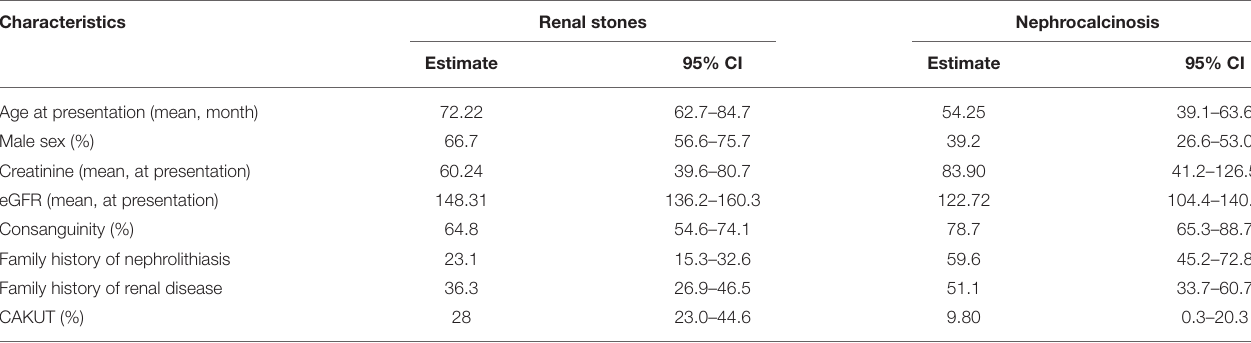
TABLE 2 | Patients’ baseline demographic and disease characteristics. Characteristics